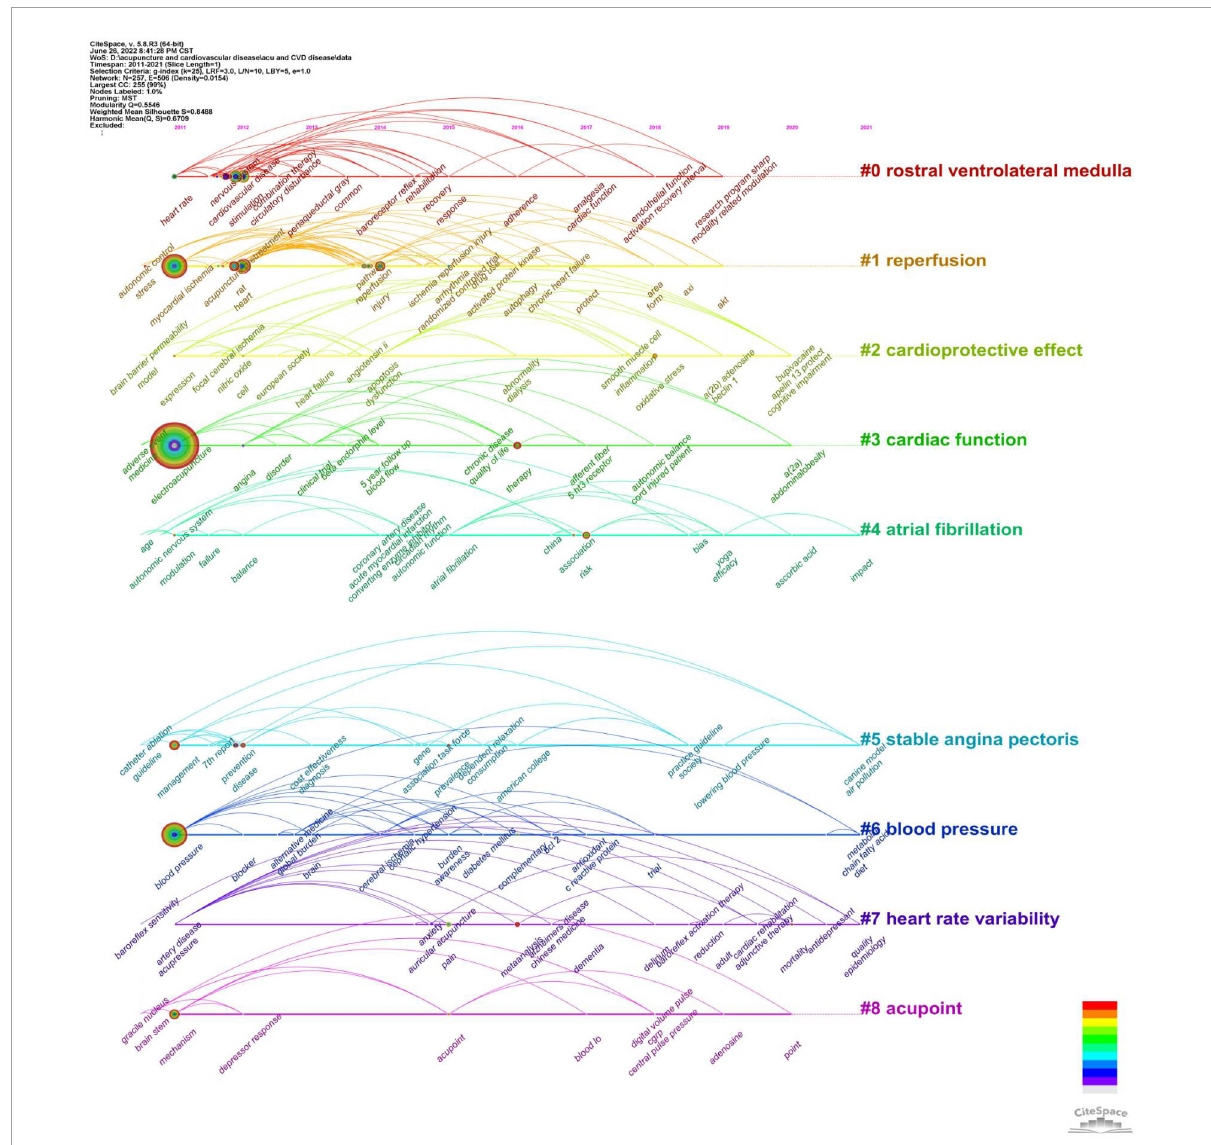
FIGURE8 Timeline view of the keywords about acupuncture on cardiopathy. The top nine clusters were arranged on a horizontal timeline, and the direction of time points to the right from 2011 to 2021. The horizontal lines are timelines, with different color in each cluster. The tree rings represent occurrence of keywords, and the larger rings represent more frequency of occurrence. The camber line above the horizontal line represents the co-occurrence relationship between